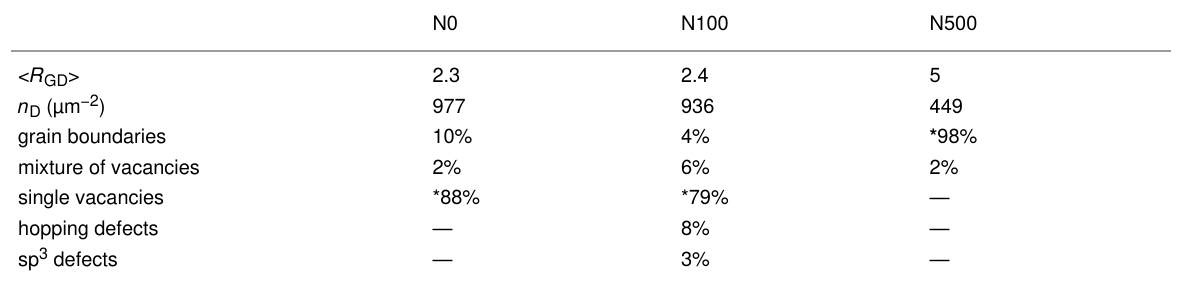
Table 3: Average ratio of G and D bands (< R GD >), defect density ( n D ) and percentage defect identification in graphene on NWs with different varia- tions in height. The most common defect in each sample is indicated by an asterisk.